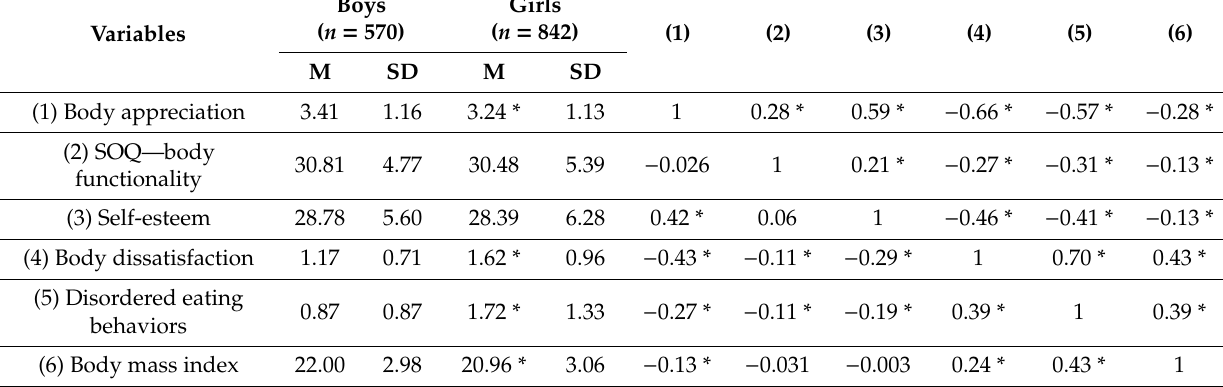
Table 5. Comparison of means in boys and girls and correlations between body appreciation and additional measures included in the study (the Lithuanian adolescent sample, n =